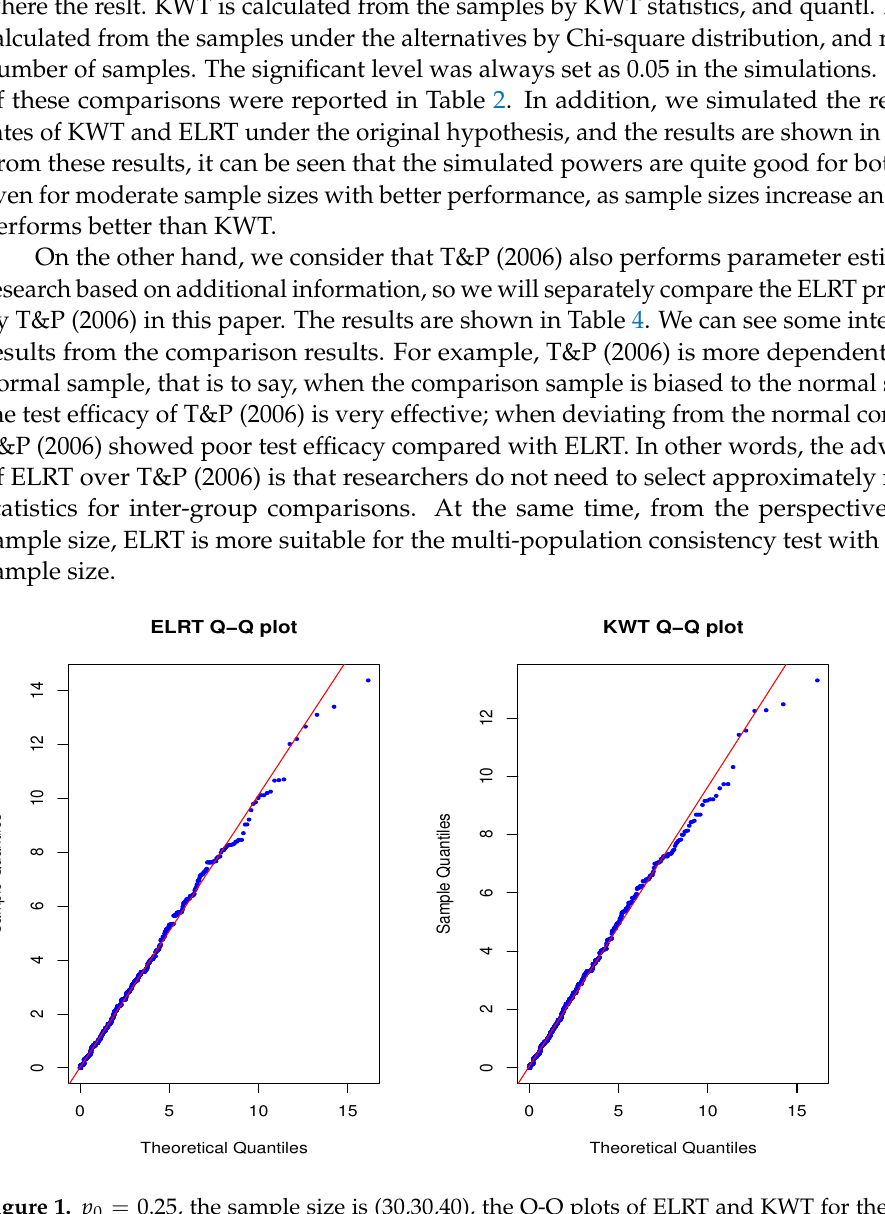
Figure 1. p 0 = 0.25, the sample size is (30,30,40), the Q-Q plots of ELRT and KWT for the overall comparison of the 3 Bernoulli